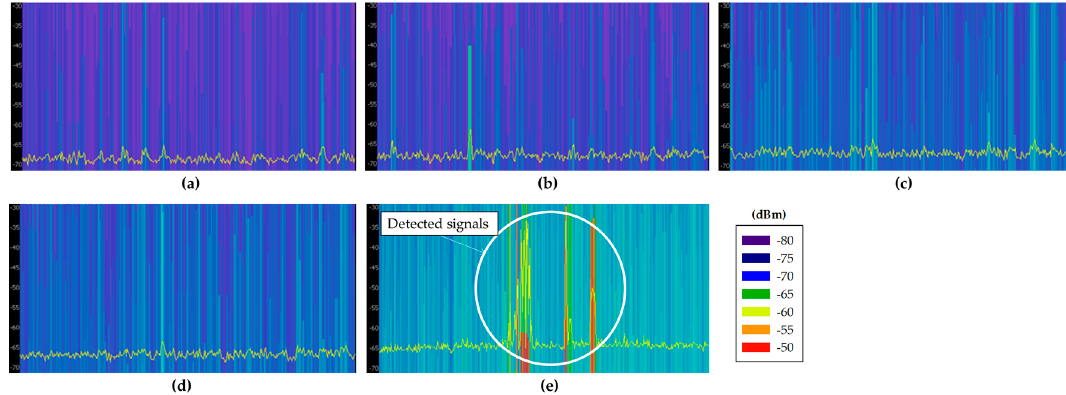
Figure 6. Measured spectrograms at 868 MHz central frequency with 30 MHz bandwidth: ( a ) within Box 2; ( b ) within Box 18; ( c ) aisle in front of Box 6; ( d ) aisle in front of Box 18; and ( e ) in the middle of the scenario (bandwidth of 300 MHz).